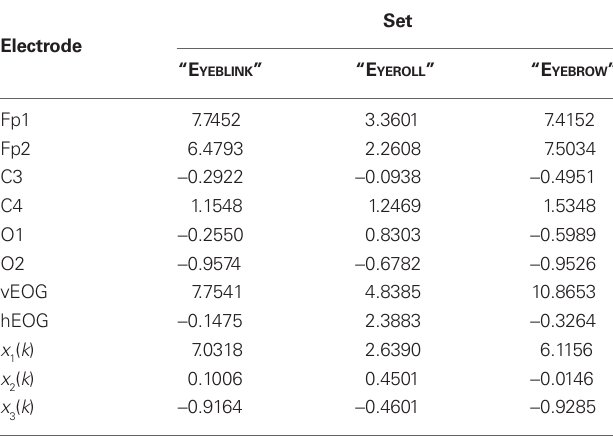
Table 3 | Normalized kurtosis values of the recorded EEG/EOG signals in real- and complex-valued form.